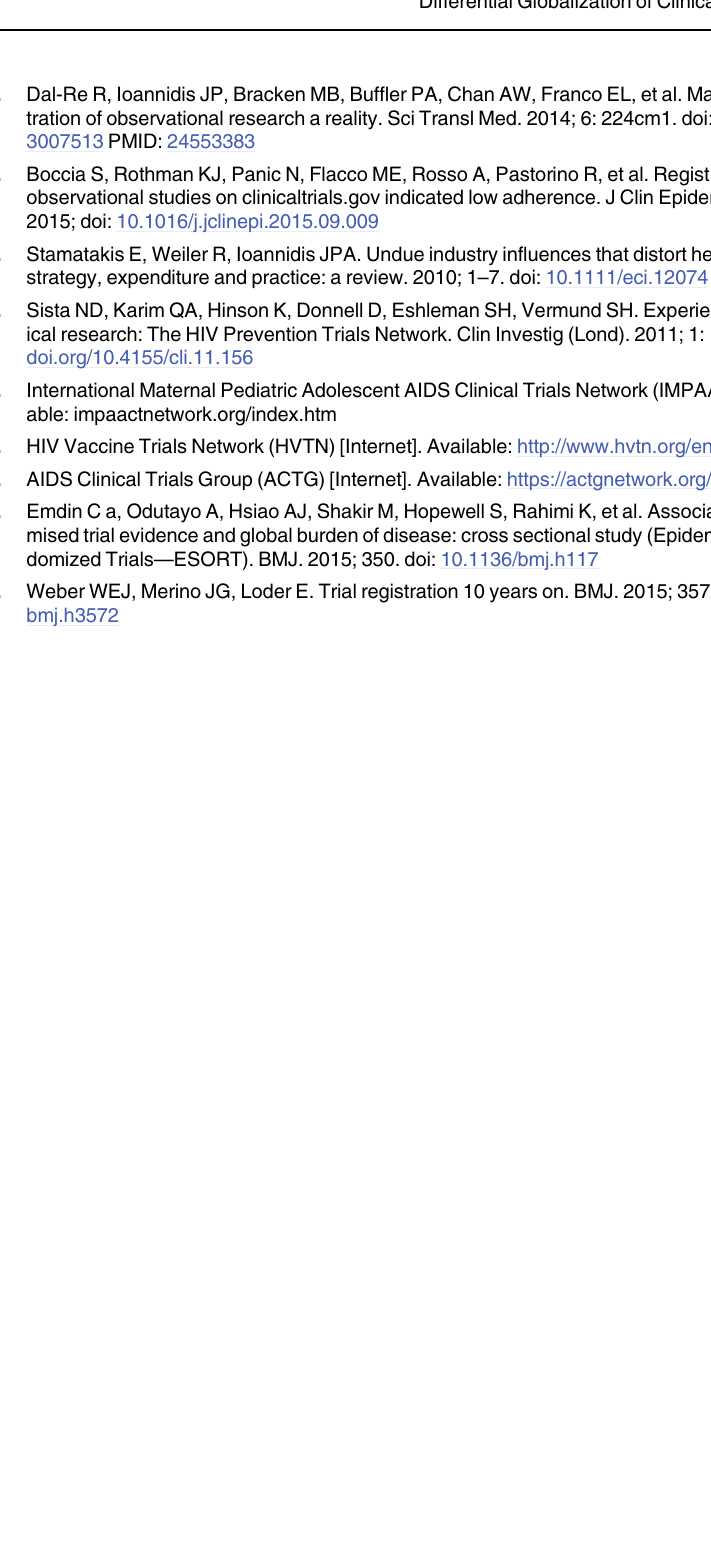
PLOS ONE | DOI:10.1371/journal.pone.0145122 December 14,